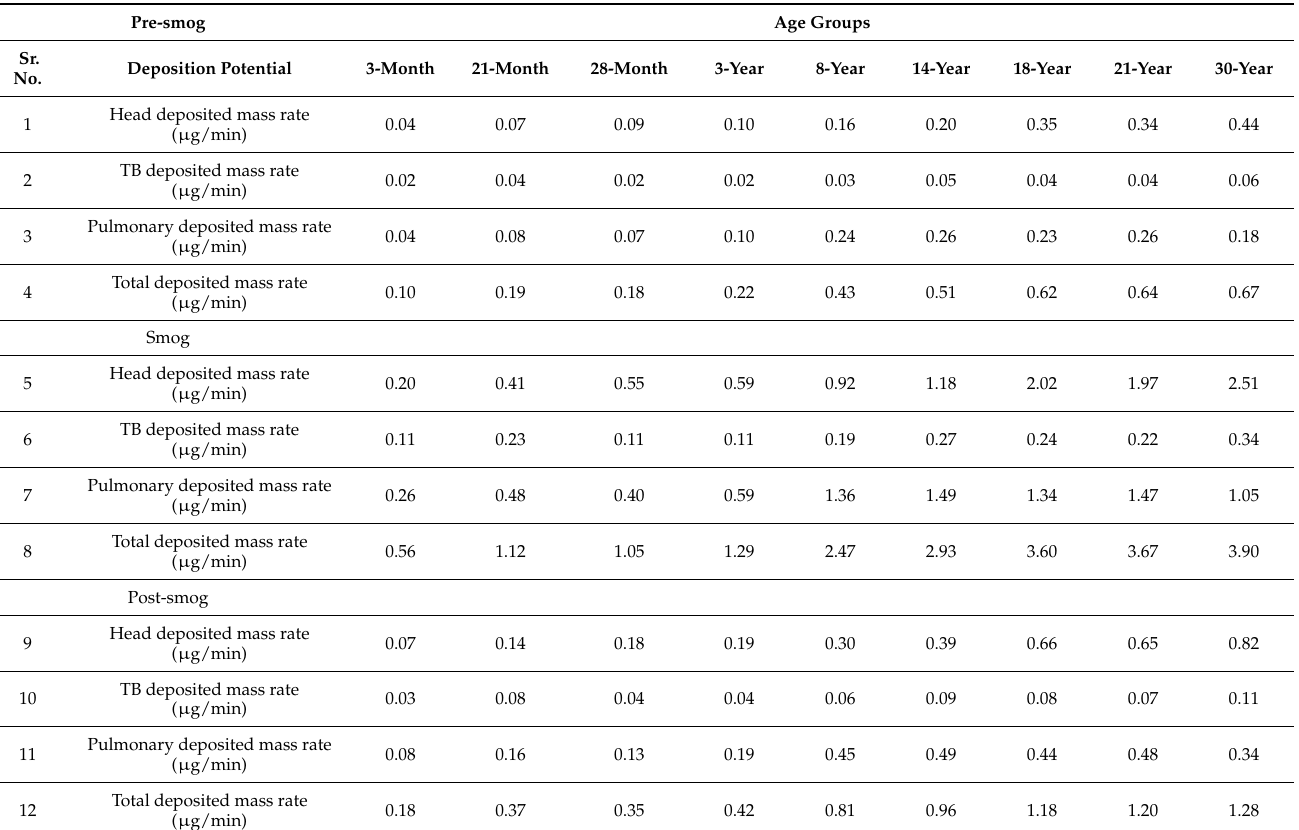
Table 6. PM 2.5 deposited mass rate ( µ g/min) for different age groups during pre-, during, and post-